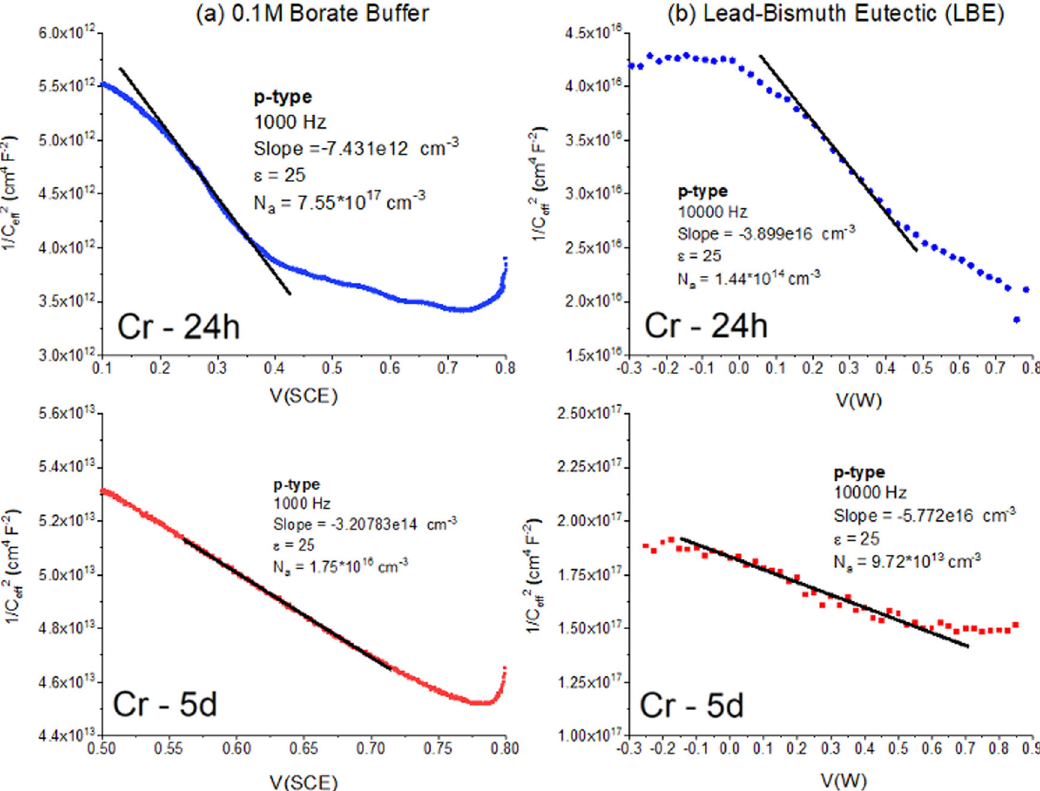
Fig. 10 Mott-Schottky plots displaying the effective capacitance (Ceff -2 ) versus applied voltage of 24 h and 5 day air oxidized chromium. Tests were conducted in a 0.1 M borate buffer and b LBE. The solid line represents the linear region fi tted with Eq. (2). The reference electrode was saturated calomel (SCE) in borate buffer and tungsten wire (W) in LBE. All error bars are smaller than the size of the symbols used for data points representation and reside within the respective